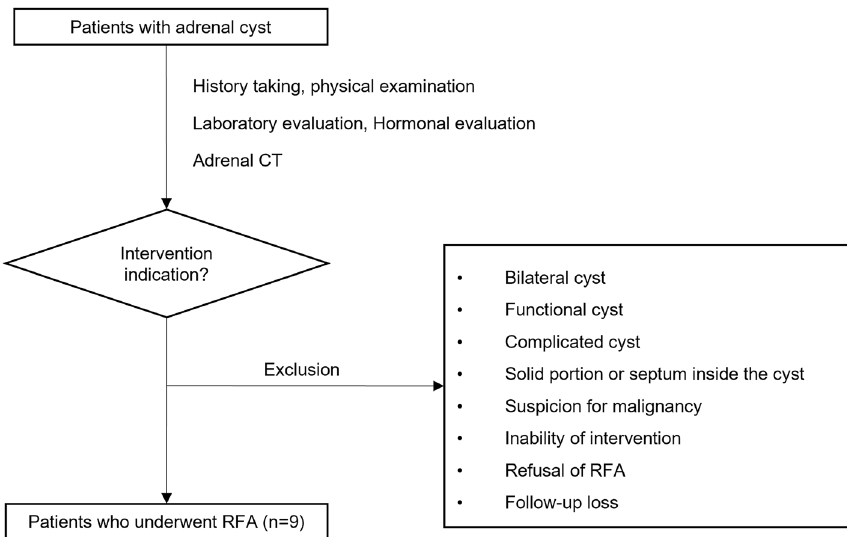
Figure 1. Flow chart of patient selection. RFA, Radiofrequency ablation; Adrenal CT, Adrenal computed